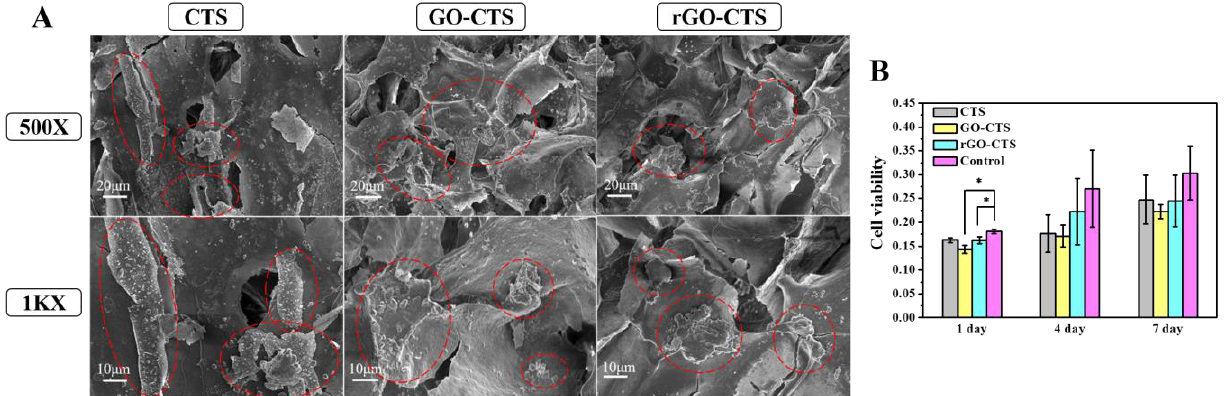
Figure 6. Biological assays of the CTS, GO-CTS, and rGO-CTS cryogels. ( A ) The SEM images of cells attached on the surface of the CTS, GO-CTS, and rGO-CTS cryogels, the cell clusters are represented by red dotted areas; ( B ) cell viability on the CTS, GO-CTS, and rGO-CTS cryogels. Data are presented as mean ± SD ( n = 3), * p < 0.05.